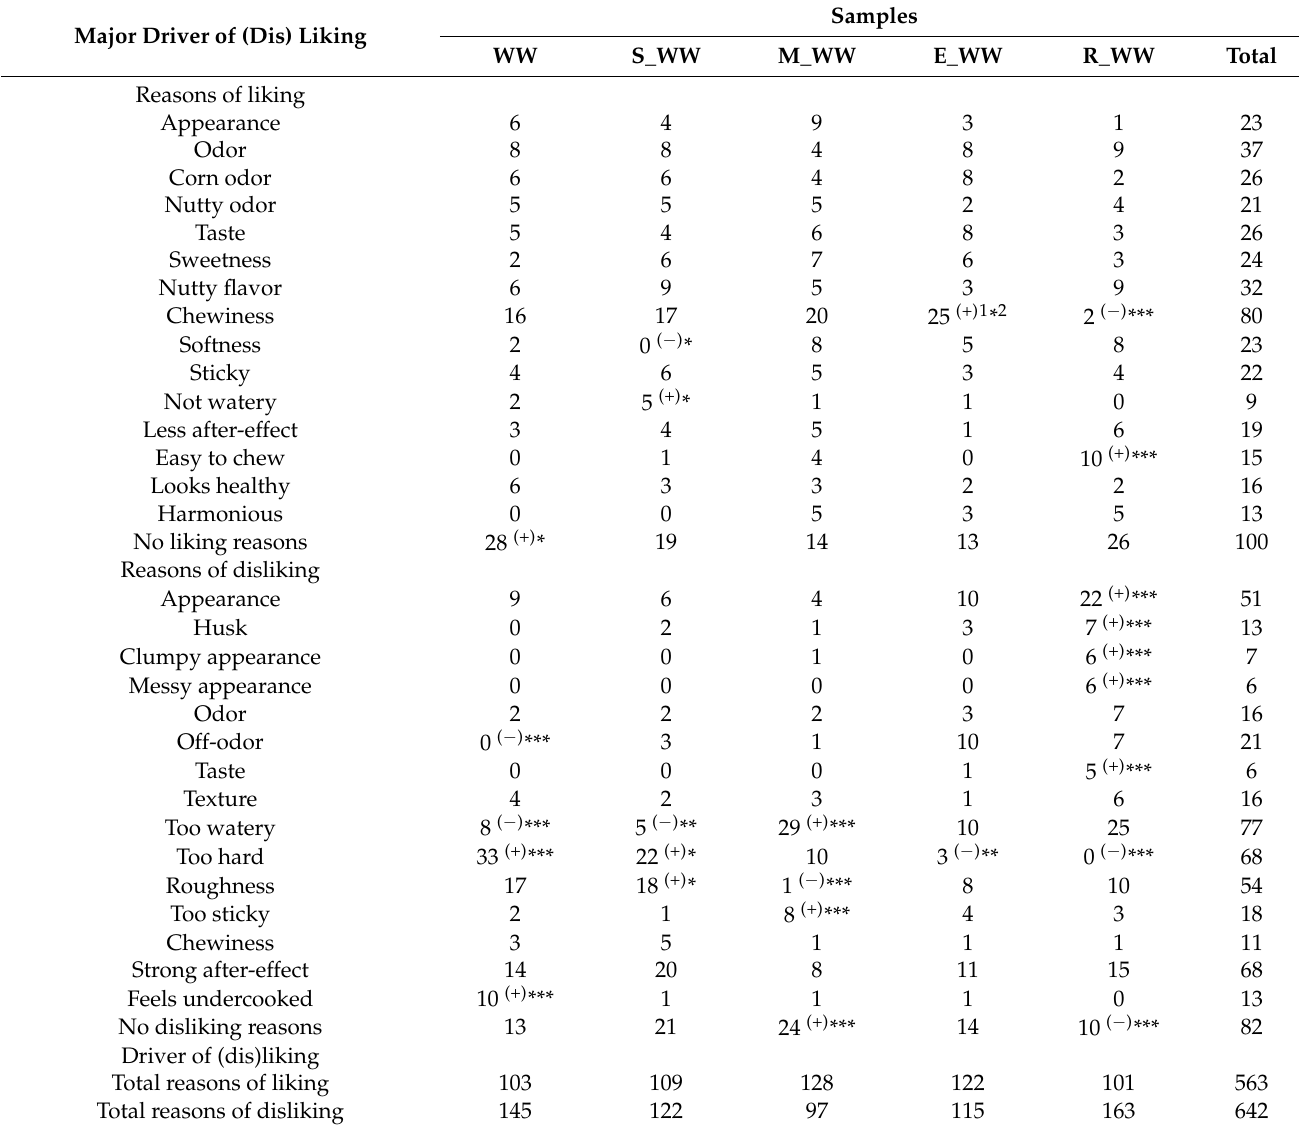
Table 3. The frequency of the major reasons of liking and disliking for cooked rice samples by more than 5% of consumer in the free comment as a response to open-ended